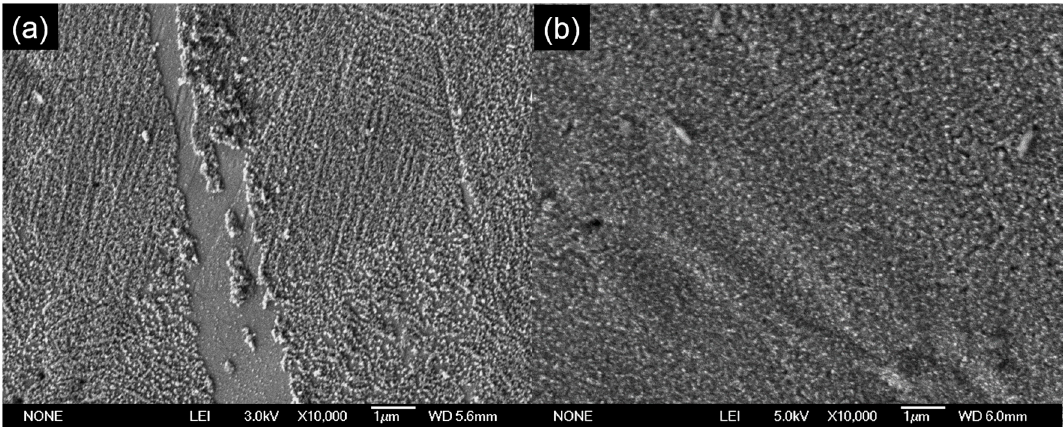
Figure 3. SEM images of TiO 2 on stainless steel by Spray-ILGAR technique using 6.83 mM of TiO 2 precursor, heating temperature of 460 °C and ( a ) shorter spraying time (6 min) and ( b ) longer spraying time (24 min).